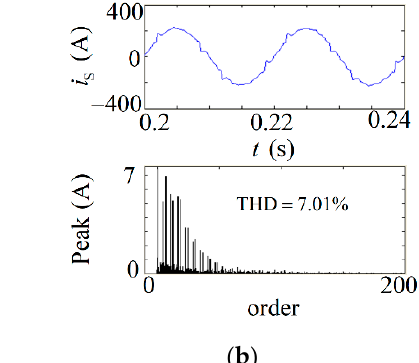
= 0.4 K , and a double- , and a double-